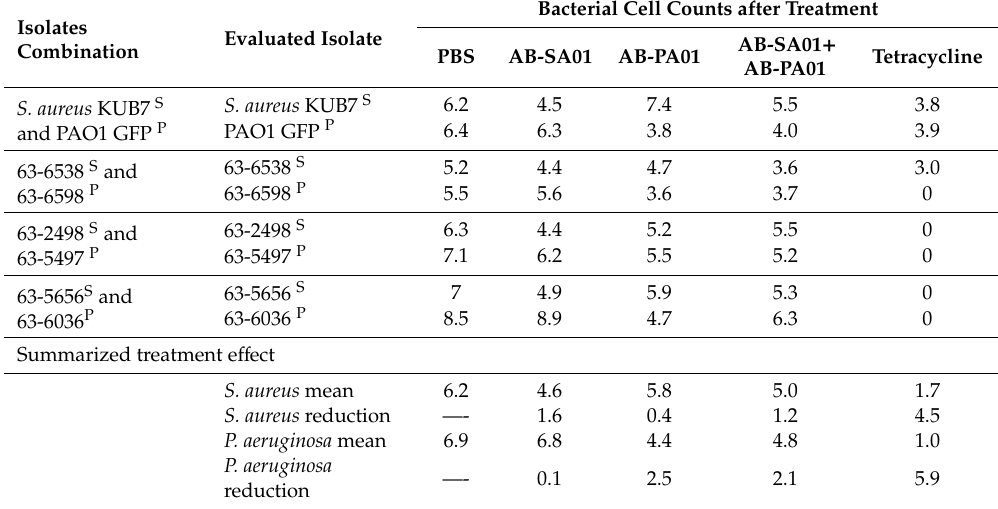
Table 2. Bacteria count (log 10 (CFU / mL)) of S. aureus and P. aeruginosa in mixed-species biofilms after 24 h phage cocktails, tetracycline, and PBS